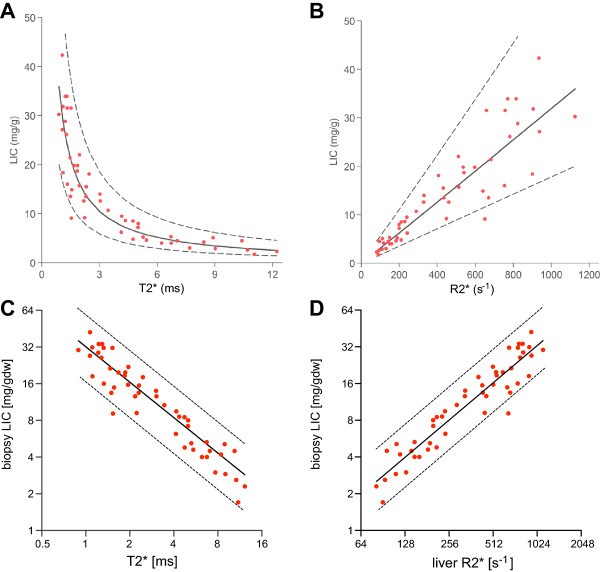
The calibration of T2* and R2* models for LIC estimation. (A) The relationship of liver T2* to LIC obtained by biopsy in 50 samples. The regression fit from Figure 
2C was plotted onto the data after exponentiation: LIC = 31.94(T2*)-1.014 with 95% CI 27.8 to 36.7 (87-115%) for the first term and -1.118 to -0.91 (110-90%) for the exponent. (B) The relationship of liver R2* (=1000/T2*) to LIC of the data in 2A, with regression line from the model in 2D after exponentiation: LIC = 0.029R2*1.014; 95% CI 0.016 to 0.054 (55-186%) for the first constant, 0.910 to 1.118 (90-110%) for the exponent. (C) Log-log plot of LIC versus liver T2*: Pearson r = -0.94 (95% CI -0.97 to 0.91, p < 0.0001); linear regression: ln(LIC) = 3.464-1.014ln(T2*); slope SE = 0.052, 95% CI -1.118 to -0.9 (110-90%); intercept SE = 0.069, 95% CI 3.325 to 3.603 (96-104%), r squared 0.89. (D) Log-log plot of LIC versus liver R2*: Pearson r = 0.94 (95% CI 0.90 to 0.97, p < 0.0001); linear regression: ln(LIC) = 1.014ln(R2*)-3.54; slope SE = 0.052, 95% CI 0.910 to 1.118 (90-110%); intercept SE = 0.30, 95% CI -4.152 to -2.928 (117-83%); r squared 0.89.